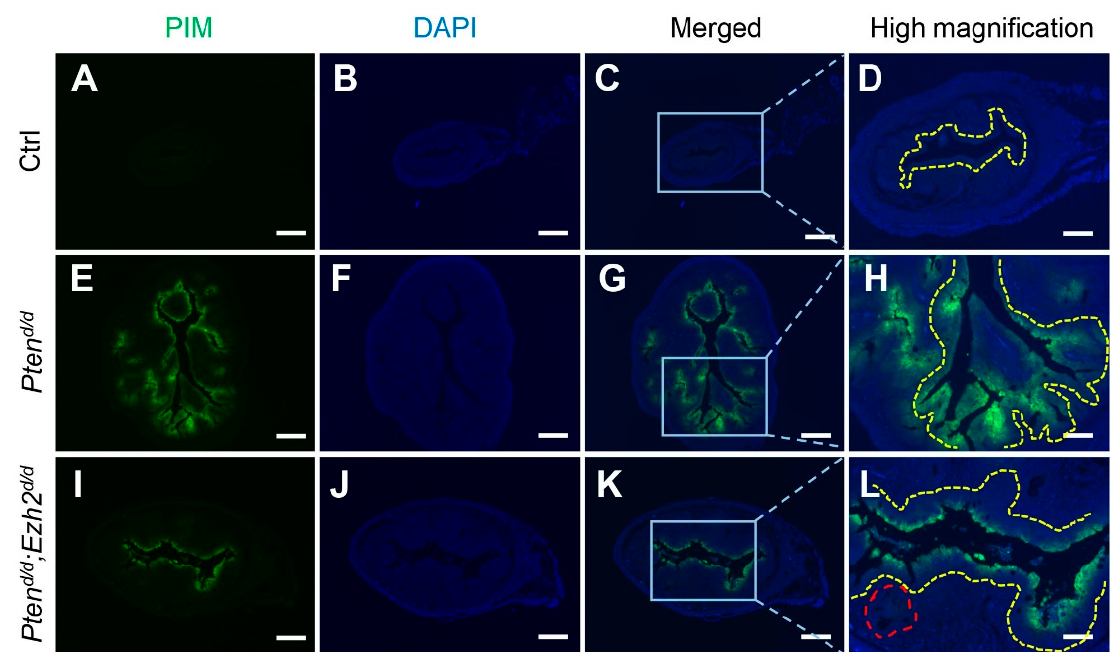
Figure 7. Reduced hypoxia in the uteri of Pten d/d ; Ezh2 d/d mice compared with Pten d/d mice. ( A – L ) Immunofluorescence staining of pimonidazole protein adducts using one-month-old Pten f/f (Ctrl) , Pten d/d , and Pten d/d ; Ezh2 d/d uteri. PIM, pimonidazole protein adducts. Panels ( D , H , L ) are high power images of the boxed areas of panels ( C , G , K ), respectively. Yellow dashed lines denote the luminal epithelial component or epithelia adjacent to the uterine lumen. Note the reduced extent of epithelial hypoxia and diminished hypoxia in the glandular-like component (red dashed line) in Pten d/d ; Ezh2 d/d uteri. At least three independent mice were examined for each genotype. DAPI was used to coun-